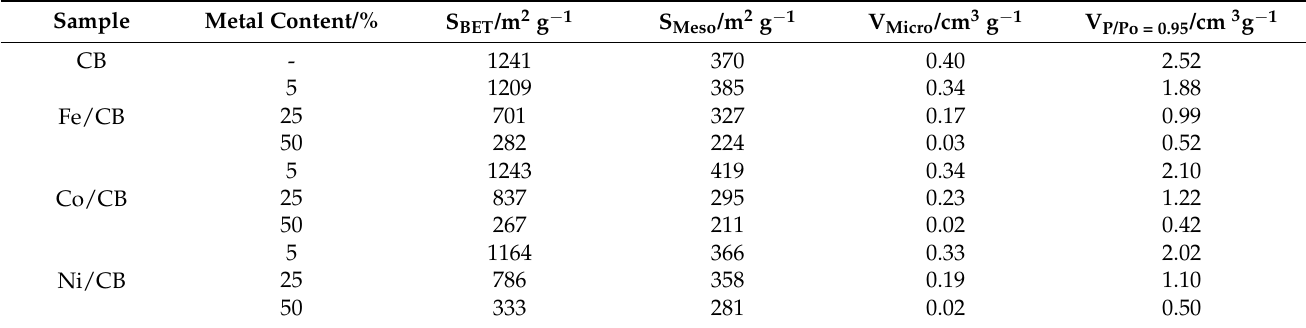
Table 1. Textural properties of the catalysts supported on CB.